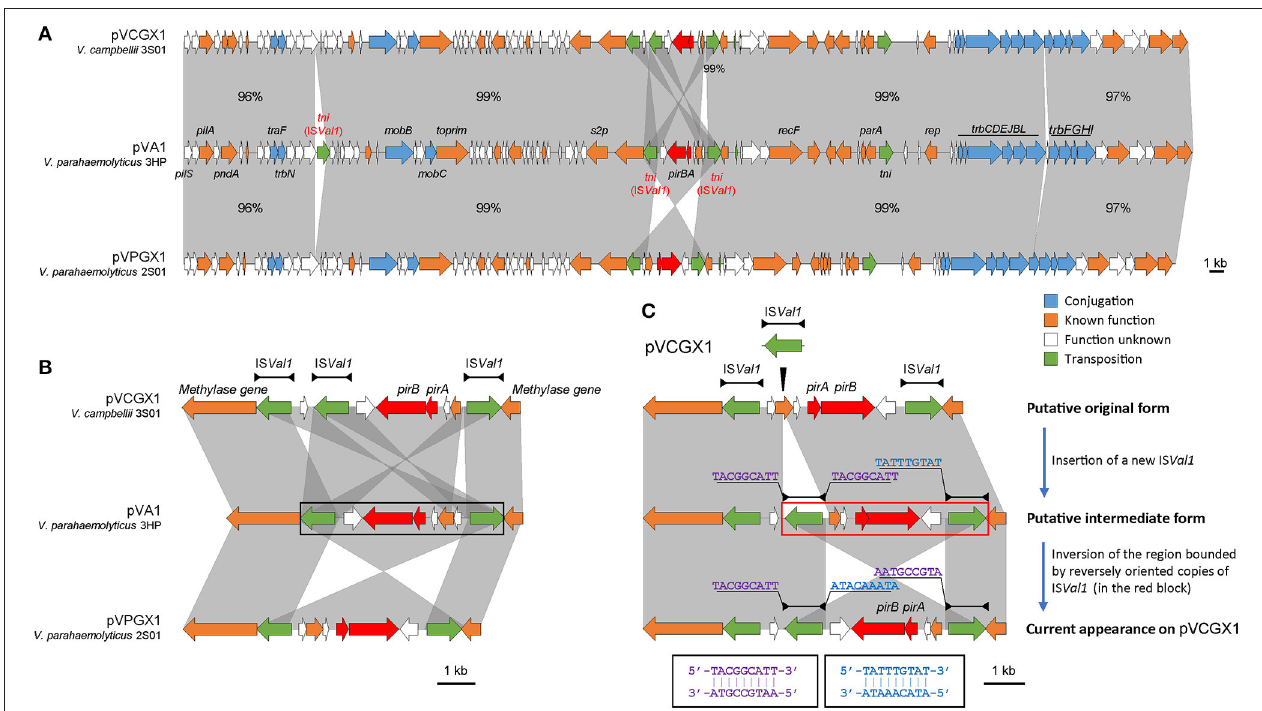
FIGURE 4 | Analysis of pirAB vp -bearing plasmids pVCGX1 and pVPGX1. (A) Comparison of plasmids pVCGX1 and pVPGX1 with pVA1. Percentages indicate the identities in nucleotide level between syntenic regions. Percentages are not given for 100% identical regions. (B) A zoom-in view of the genetic context of pirAB vp . Horizontal lines shown above the schematics, with both ends demarcated by solid triangles to indicated IRs, represent the IS Val1 . Black block denotes the 5.5-kb pirAB vp fragment describe in the text. (C) Putative evolution process of the genetic context of pirAB vp on plasmid pVCGX1. Thin triangle indicates IS insertion. In the red block is the putative region going inversion. Nucleotide sequences flanking the IS Val1 elements are shown in 5 ′ → 3 ′ . Sequences in identical colors are reverse-complement to each other as denoted in the black blocks. Gene organization is drawn to scale. Red arrows indicate pirAB vp genes. Genes with other known functions are denoted using different colors. Syntenic regions were highlighted in